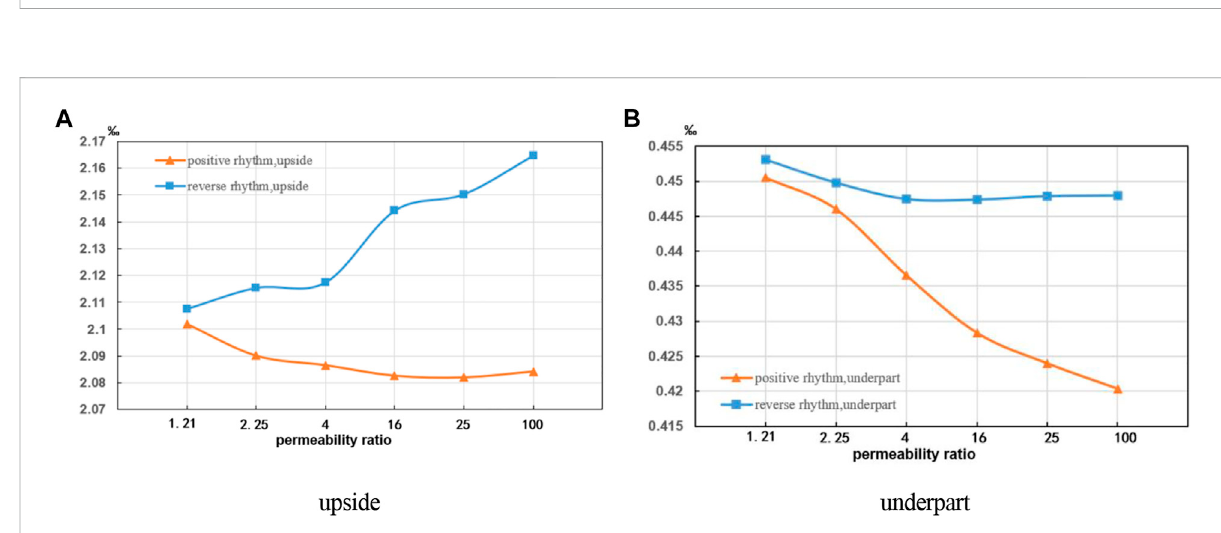
FIGURE 8 Production ratio of upper and lower reservoirs under different permeability ratios of positive and reverse